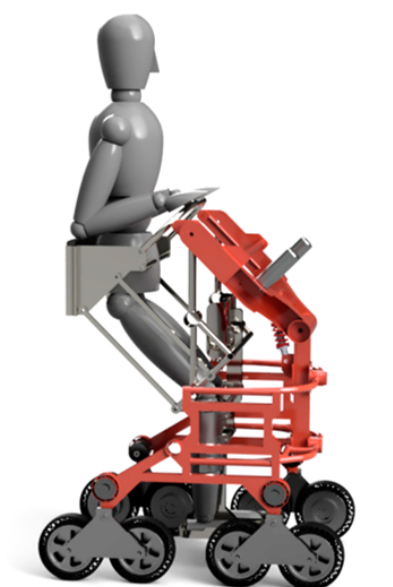
Figure 9. Seated-standing